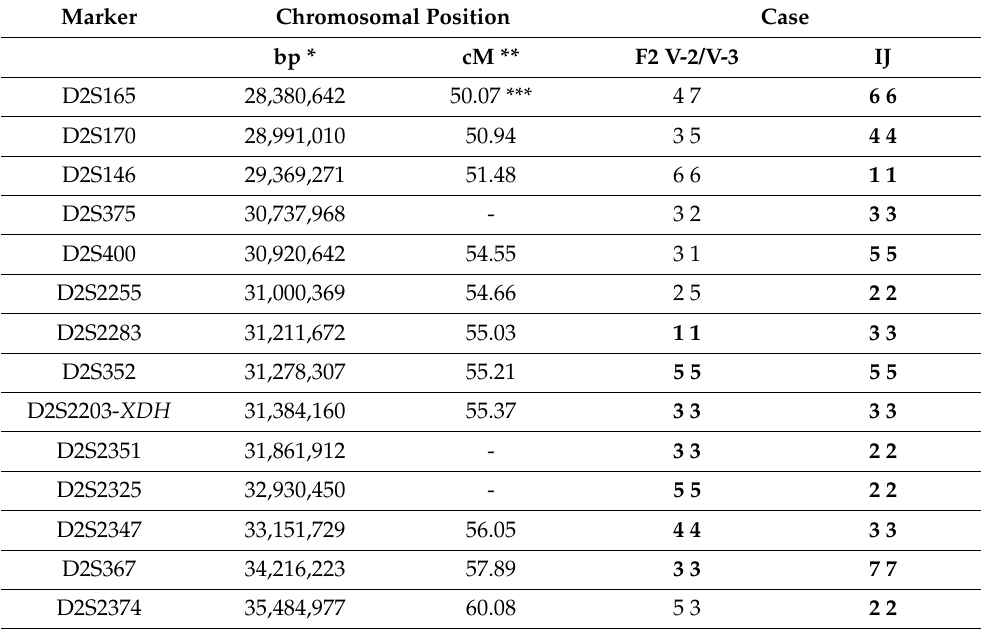
Table 4. Haplotype analysis of the markers around the XDH gene variants c.2473C>T and c.1658insC.